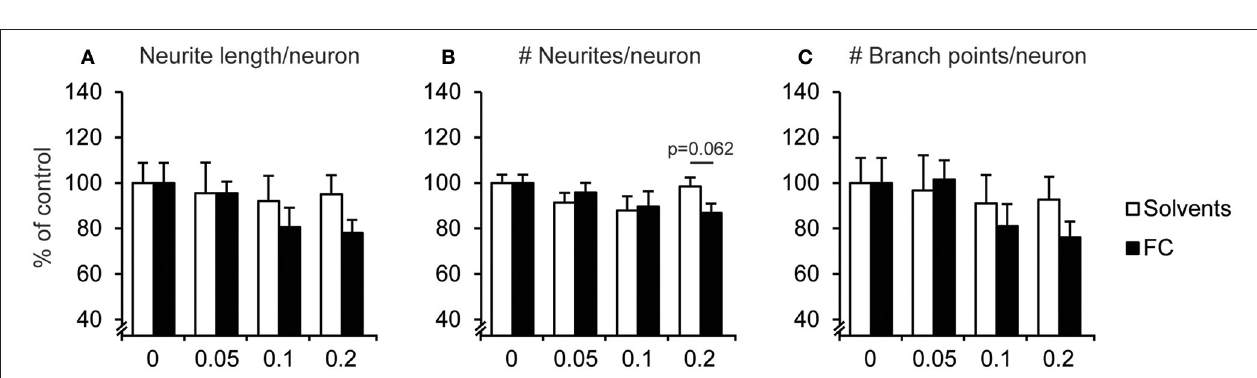
FIGURE 4 | Effect of FC on neurite morphology in primary neuron-astrocyte co-cultures. Analysis of (A) neurite length, (B) number of neurites, (C) number of branch points per neuron for: no supplementation (0) or supplementation of 0.05x, 0.1x, or 0.2x FC or solvents ( n = 7–11 wells per condition). Data were normalized to non-supplemented condition (0). Error bars represent standard error of the mean